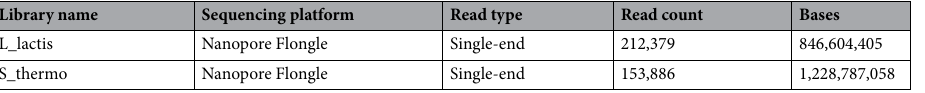
Table 6. Summary of generated sequencing data for L. latics and S. thermophilus genome used in this study.